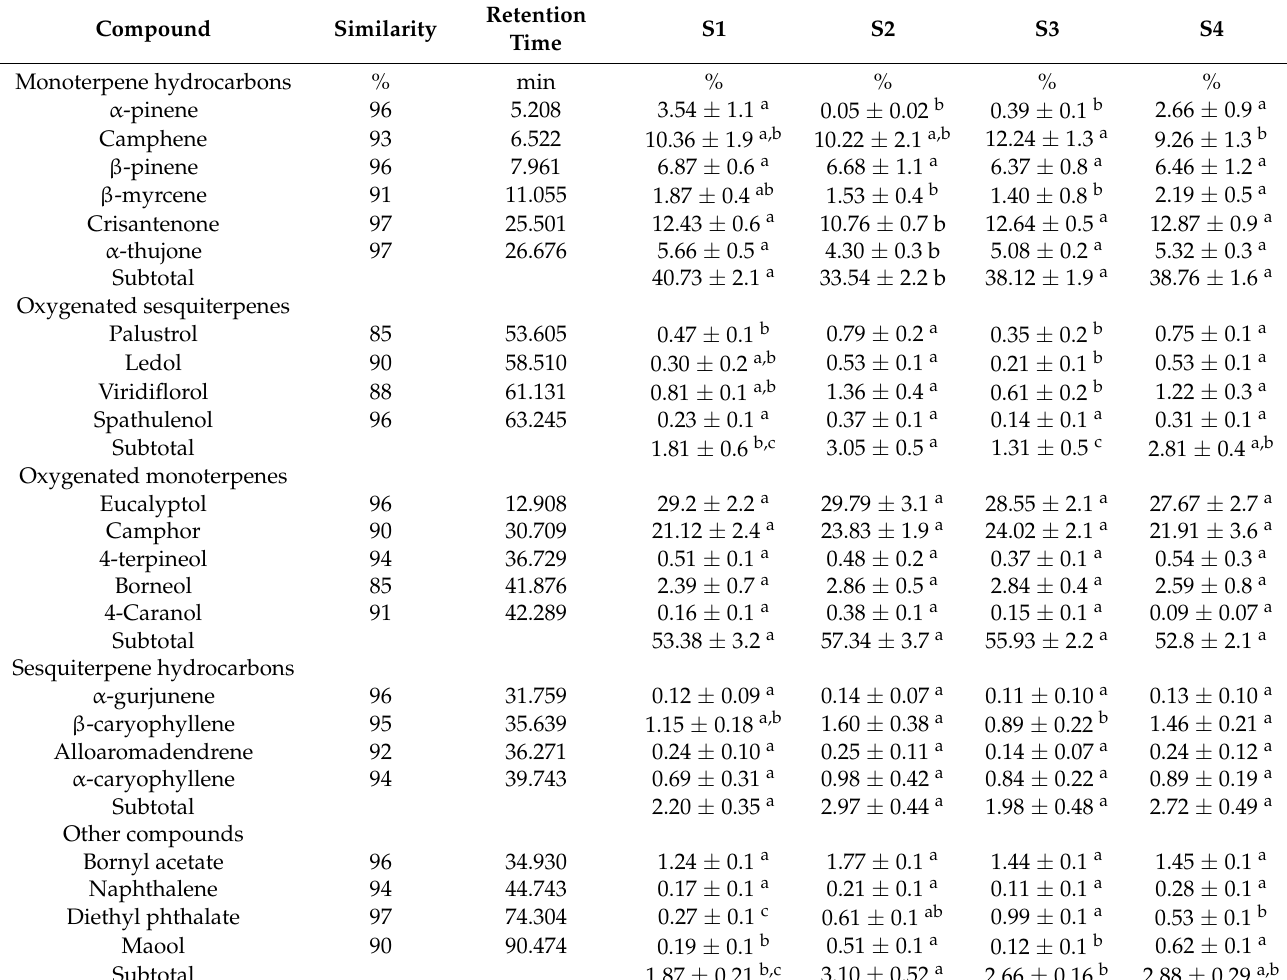
Table 4. Amount (%) of volatile compounds, grouped on the basis of their chemical characteristics and identified in the EO extracted by hydrodistillation from fresh leaves of sage plants cultivated with the four growing